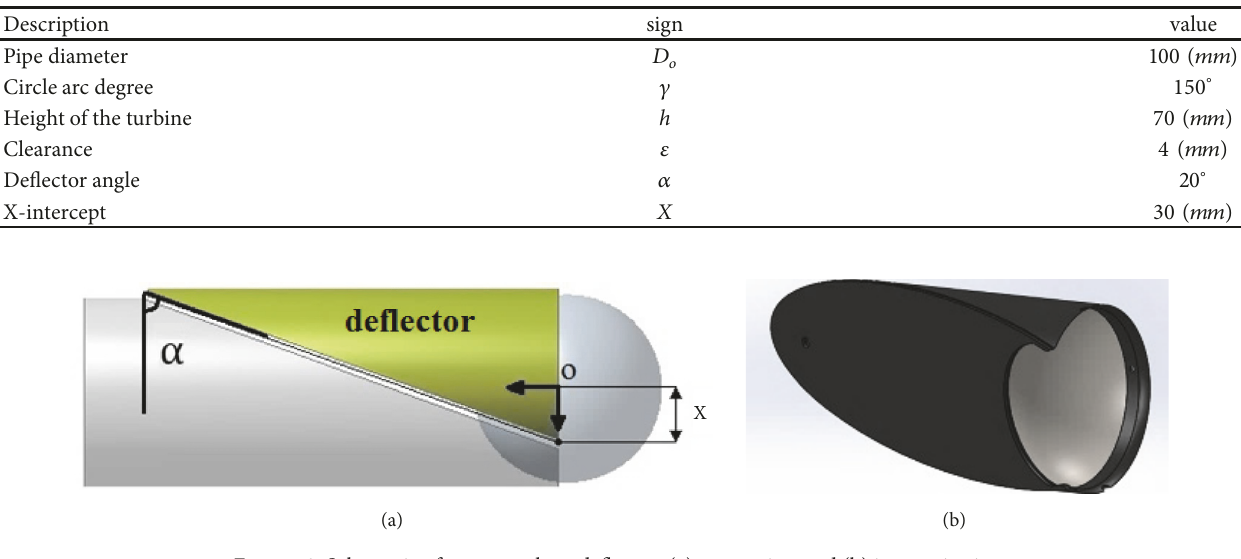
Table 1: Essential geometry of the turbine and deflector parameters value.